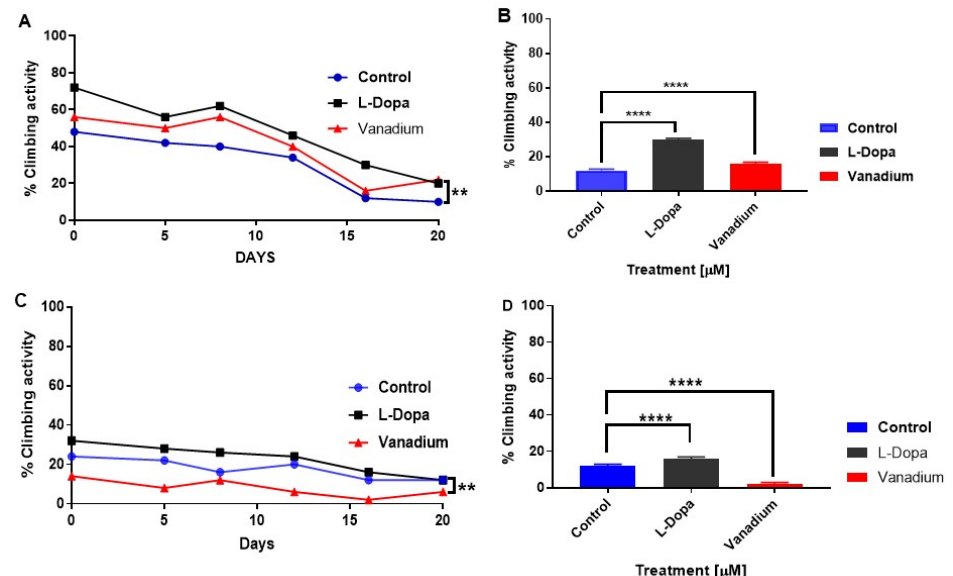
Figure 3. Effects of chronic exposure of vanadium on a percentage of flies that escaped in the climbing ability test for wild-type (WT) and PINK-1 mutant flies. In wild-type flies ( A ), a progressive decrease in the motor activity of the flies over time was observed across the three groups tested. A modest increase in motor activity can be seen with flies treated with L-dopa compared to the control group but no significant e ff ect in the group treated with vanadium ( p > 0.05). In contrast, PINK-1 flies ( C